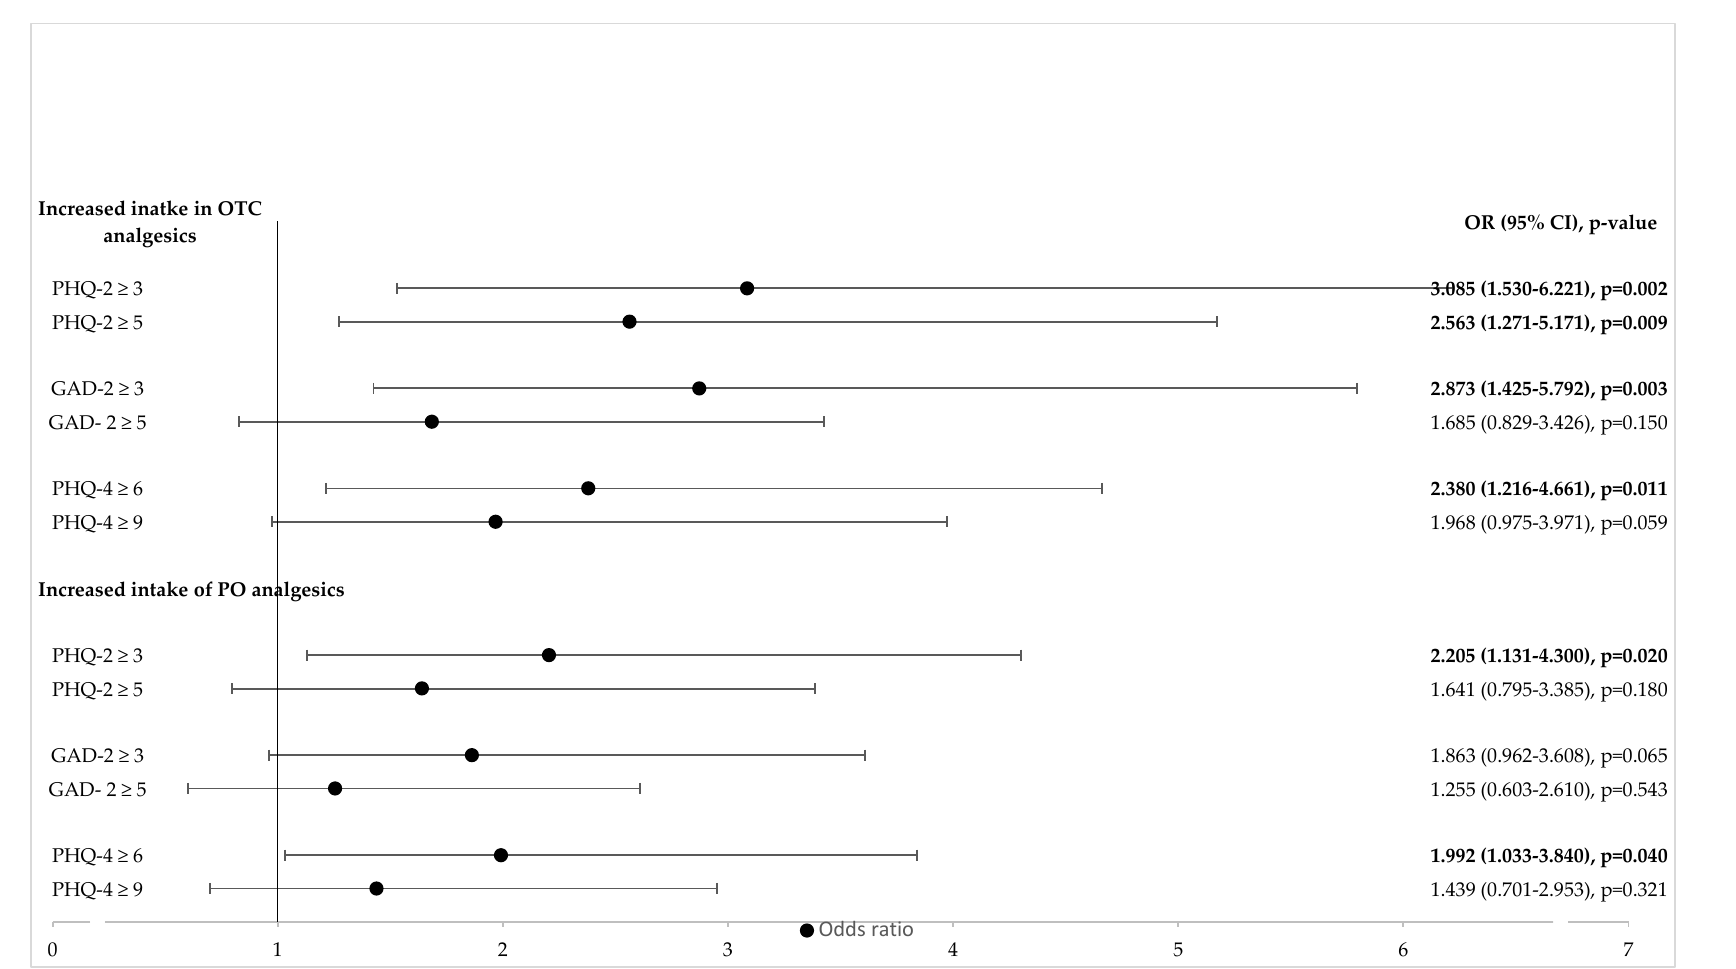
Figure 4. Influence of mental health on increased intake of OTC and PO analgesics (univariate logistic regression analysis). OTC = over the counter; PO = prescription only; OR = odds ratio; CI = confidence interval; GAD ‐ 2 = Generalized Anxiety Disorder Scale; PHQ ‐ 2 = Patient Health Questionnaire for Depression; PHQ ‐ 4 = Patient Health Questionnaire for Depression and Anxiety. Values in bold indicate statistical significance; the level of statistical significance was set to p < 0.05.